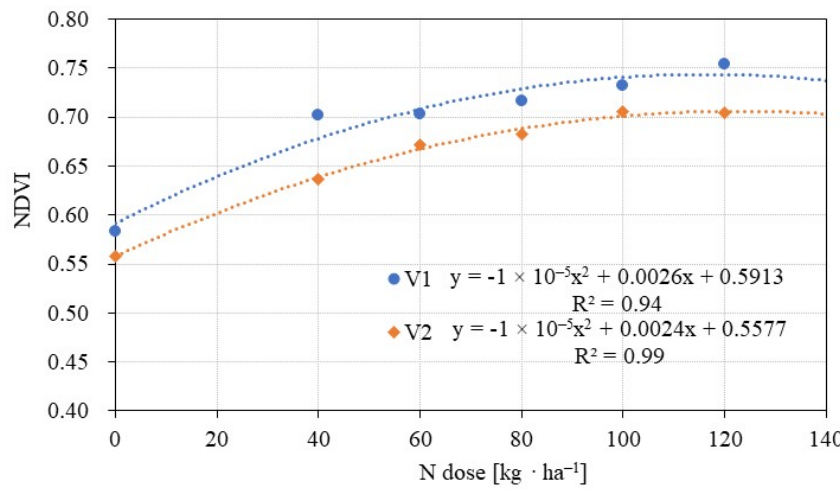
Figure 8. NDVI of winter wheat genotypes under N ‐ fertilization (22 May 2020)—BBCH 39.